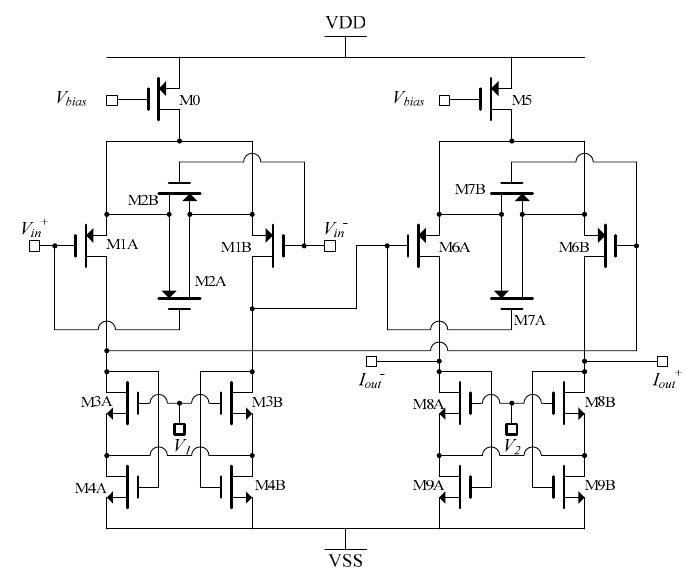
Figure 8. A high transconductance OTA [14].